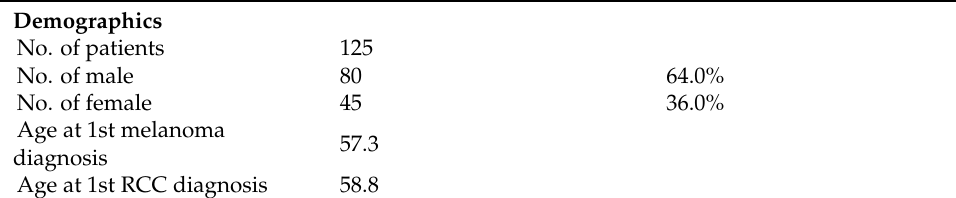
Table 1. Characteristics of the 125 patient cases diagnosed with both melanoma and renal cell carcinoma